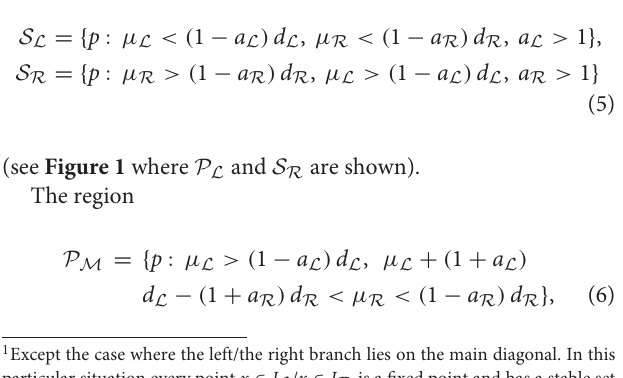
(outlined red in Figure 1 ). The related bifurcation structure— skew tent map (STM for short) structure—is described in Section